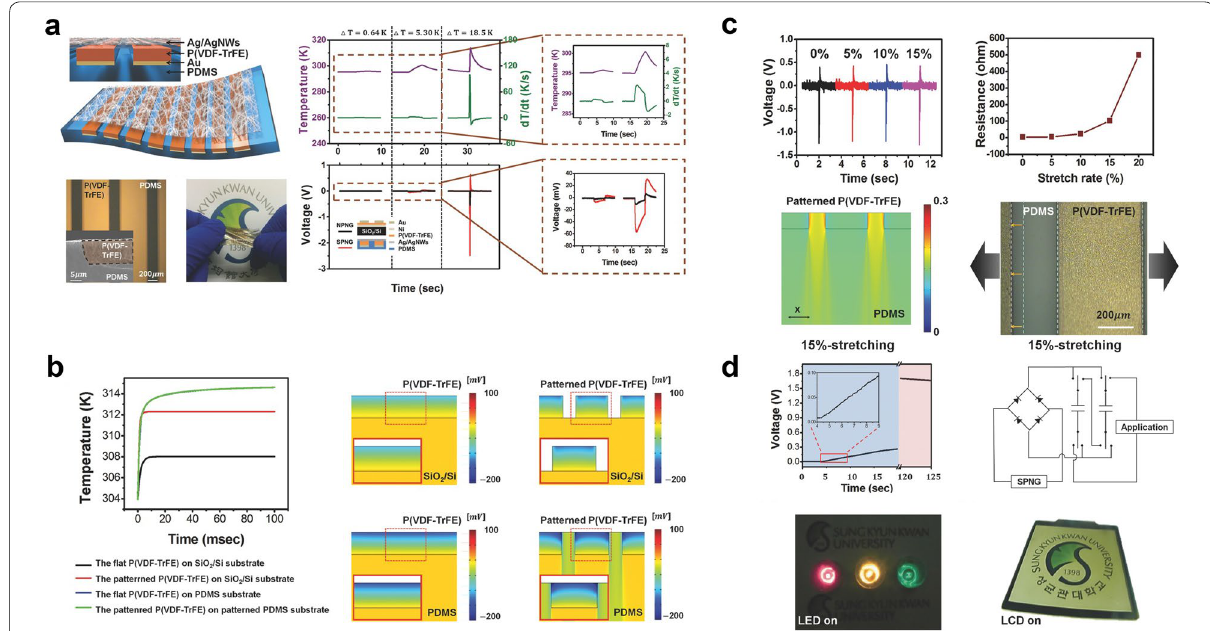
Fig. 8 a Structure of micro‑patterned P(VDF‑TrFE) based SPNG and output current comparison. b Temperature dynamics of each devices and piezoelectric potential by thermal expansion. c Mechanical stability under stretching. d Demonstration of SPNG for charging capacitor and switching on LEDs and LCD (Reproduced from [4] with copyright permission from 2015 John Wiley &